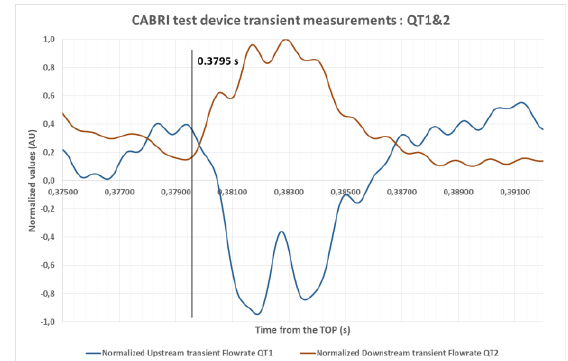
Fig. 6. Test device measurements of interest: transient flowrate